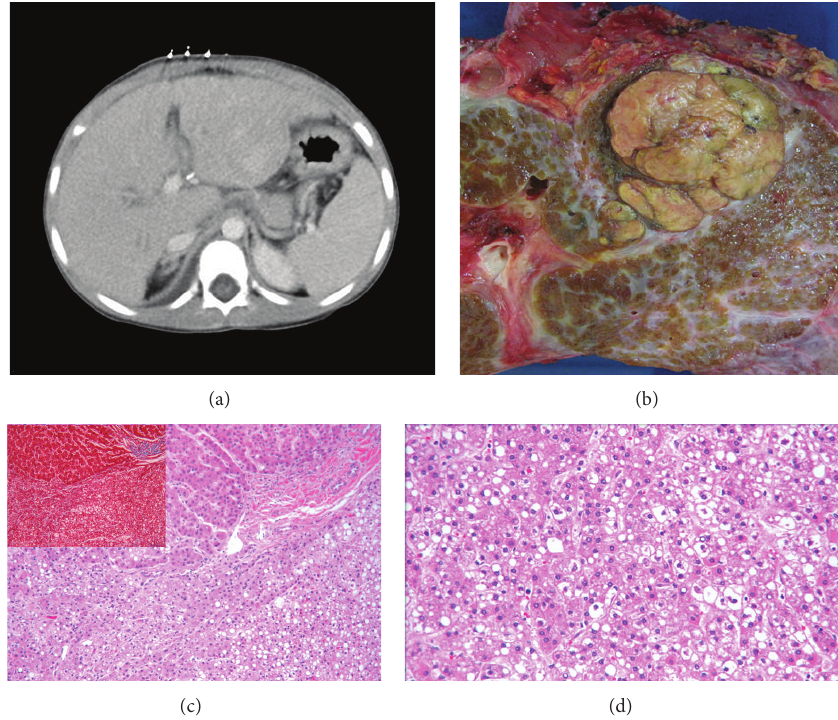
Figure 1: (a) CT scan of liver. (b) Gross picture of liver mass. (c) Microscopic picture of liver mass, H&E, 10x, with trichrome inset showing mass in lower half. (d) High magnification of mass, H&E,